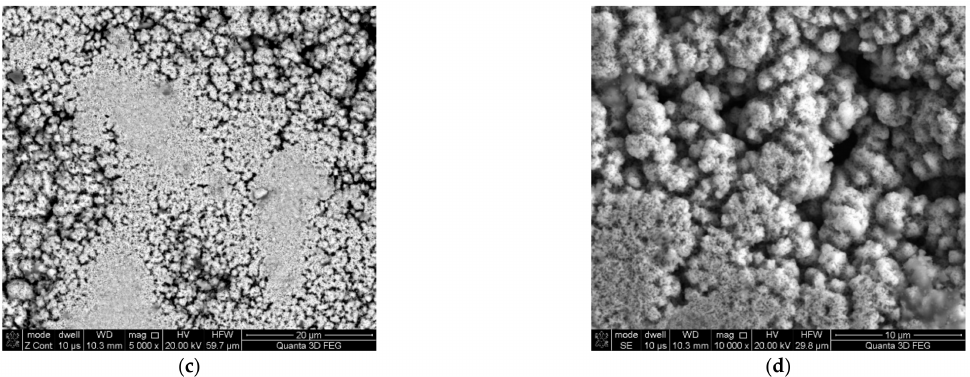
Figure 1. SEM images of the fresh catalyst surface. ( a ) catalyst granule, ( b ) 1000-fold magnification, ( c ) 5000-fold magnification, ( d ) 10,000-fold magnification.